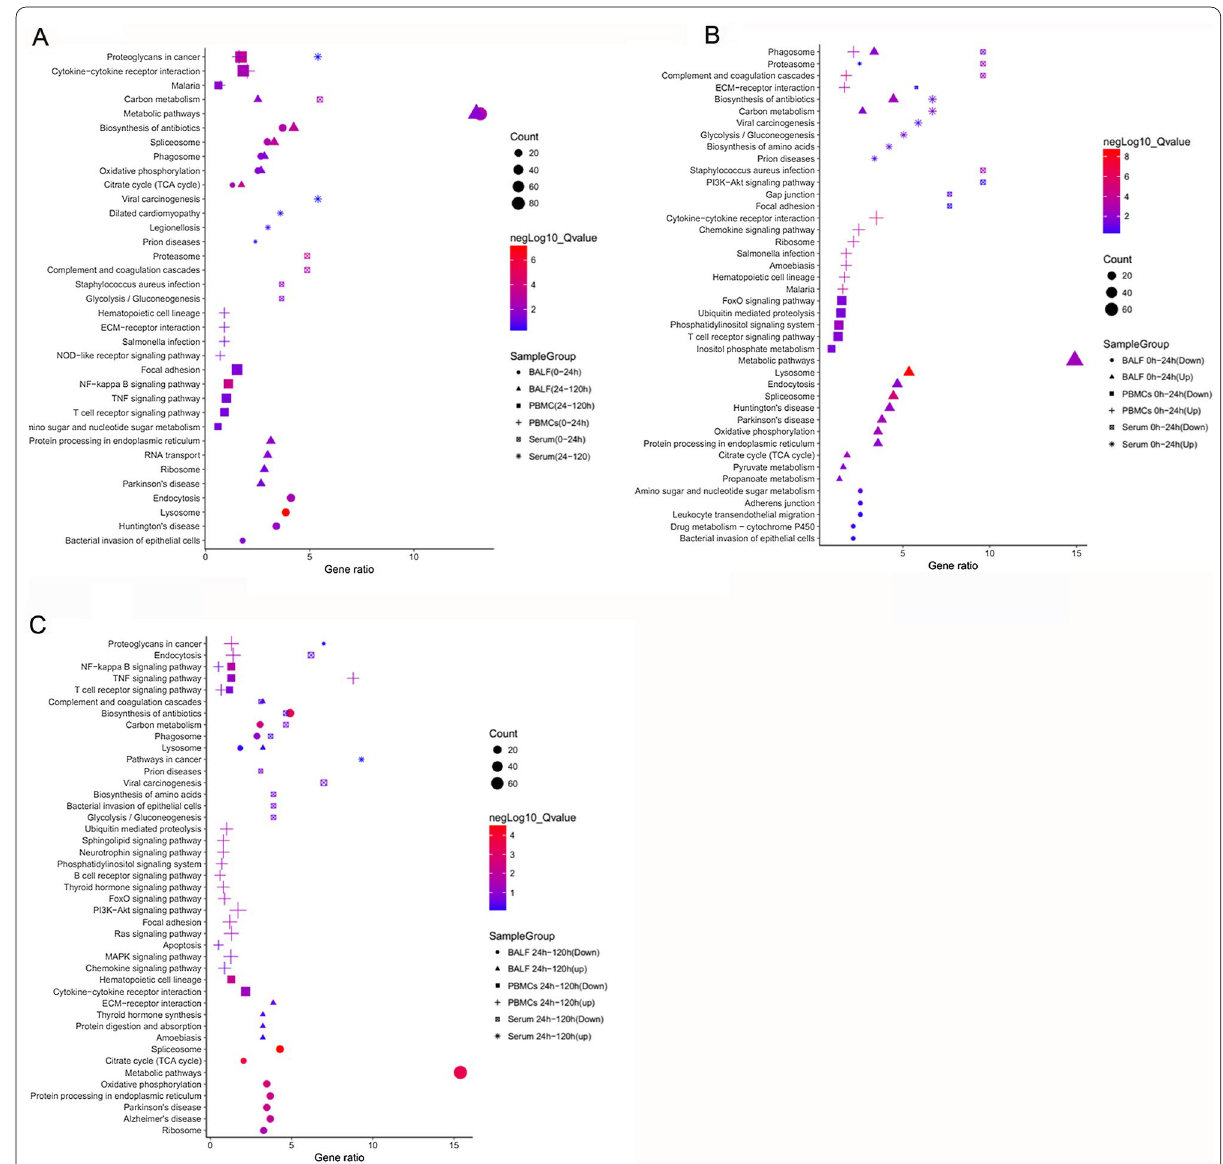
Fig. 3 KEGG enrichment analysis of DEMs in PBMCs, serum and BALF. A KEGG enrichment analysis of DEMs at different infection stages (0–24 h, 24–120 h); Up-regulation and down-regulation of DEMs were analyzed by KEGG enrichment respectively at 0–24 h ( B ) and at 24–120 h ( C ). The X-axis indicates the ratio of the DEGs enriched in this pathway to the total DEGs; the Y-axis indicates the KEGG term; the counts and negLog10_ qValue indicates the number and degree of enrichment of genes in a category, respectively. *negLog10_qValue > 1.3 were considered significantly enriched by the